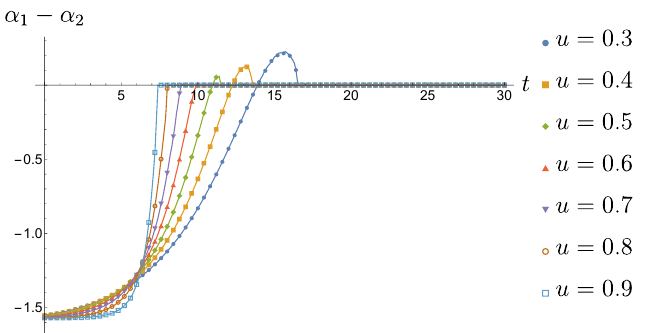
Figure 34 . Evolution of the relative orientations of type I* non-Abelian vortices during head-on scatterings with initially orthogonal orientations and velocities u = 0 . 3 , · · · , 0 . 9